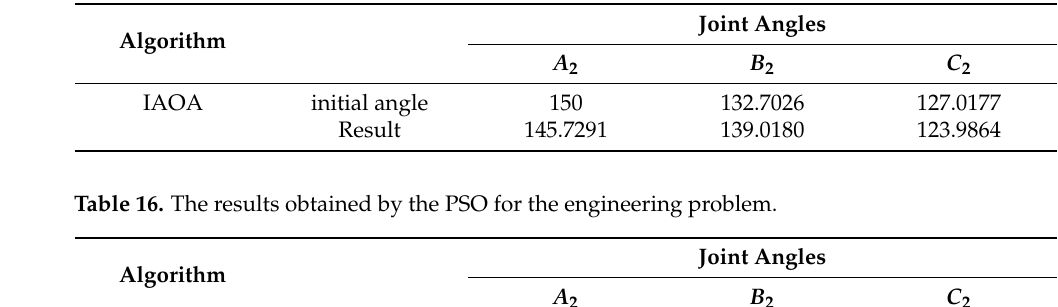
Table 15. The results obtained by the IAOA for the engineering problem.